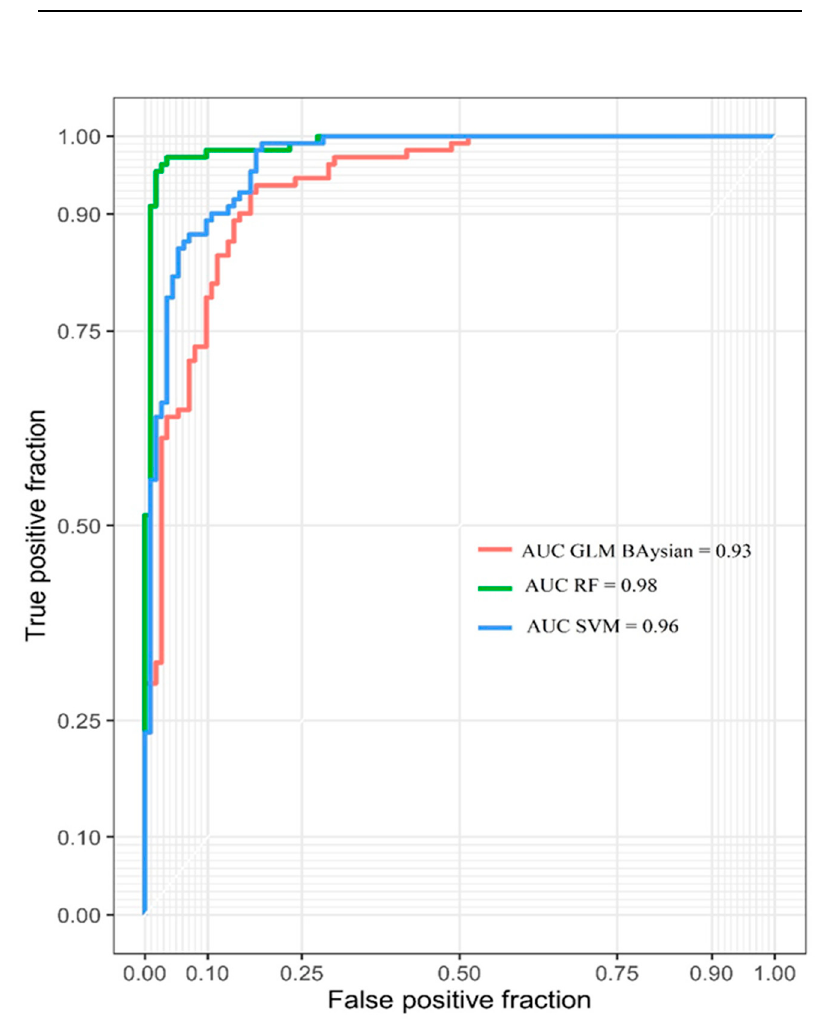
Figure 6. The ROC curve analysis for three piping models using the training dataset.